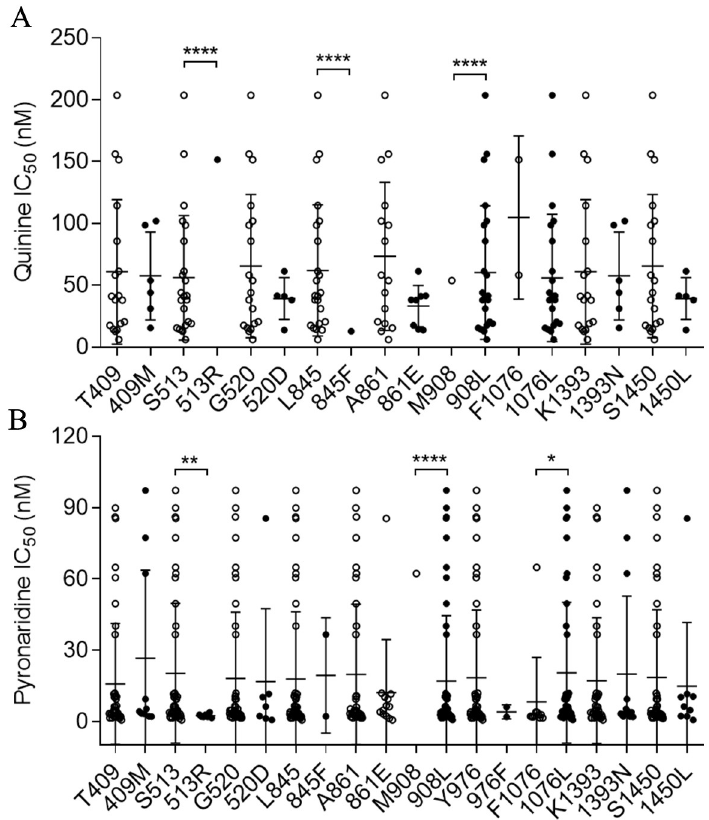
Fig 2. Association of SNPs in pvmdr1 with ex vivo susceptibilities to quinine (A) and pyronaridine (B). � , �� , and ���� indicate significant differences between the two alleles at P < 0.05, < 0.01 and < 0.0001, respectively.